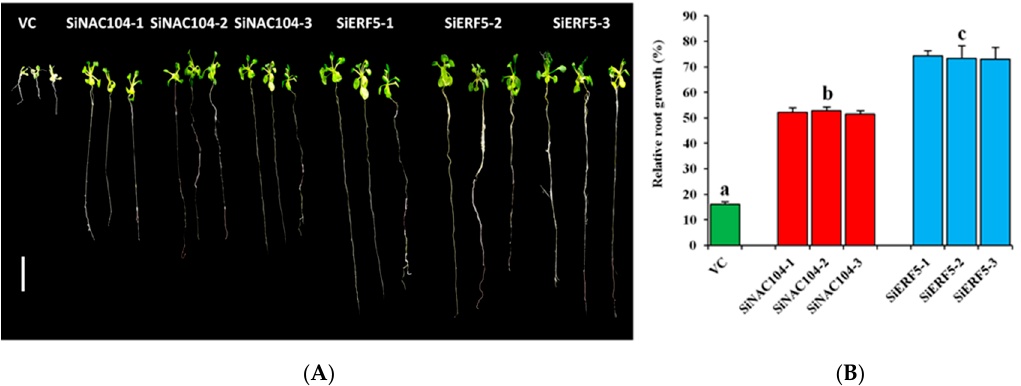
Figure 5. Functional characterization of SiERF5- and SiNAC104-overexpressing lines and their counterparts vector control (VC) plants under osmotic stress induced by 250 mM Mannitol addition to the MS medium. ( A ) Phenotypes of the transgenic and VC plants under stress. The bar represents 1 cm ( B ) relative root length estimated as the ratio of the root length recorded after 10 days under stressed and control MS mediums. Values are means ± SD from two independent measurements. Bars with different letters are significantly different ( p ≤ 0.05).